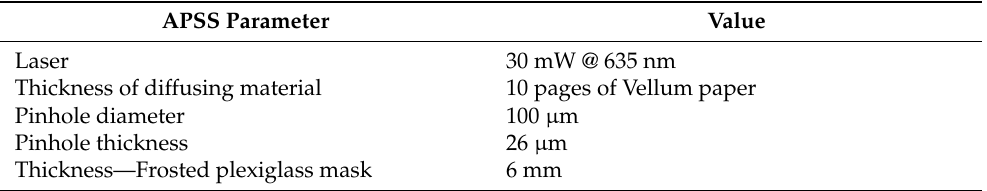
Table 5. Implementation of the APSS.